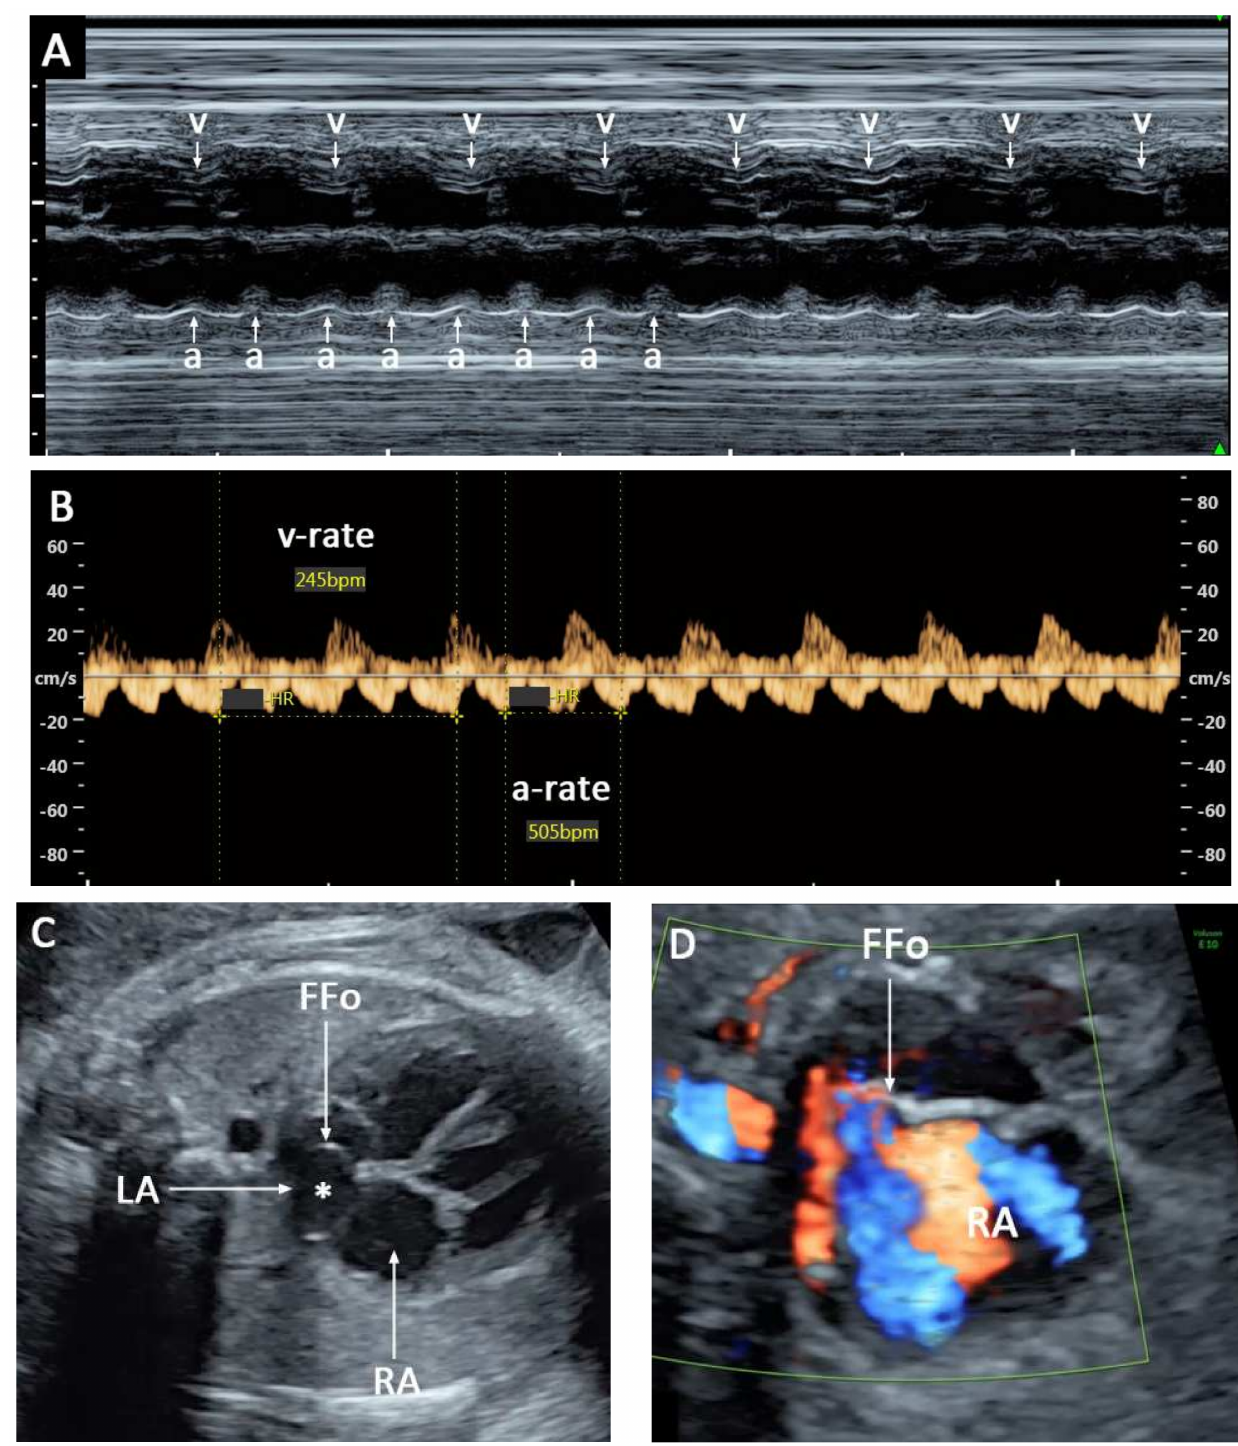
Figure 1. ( A ) M-mode shows a ventricular rate of (v) 245 bpm and an atrial rate of (a) 490 bpm; ( B ) Doppler waveforms of the renal vein (a-rate: 245 bpm) and renal artery (v-rate: 505 bpm); ( C ): Atrial septal aneurysm (*): wide excursion of the foramen ovale flap; ( D ): Color flow mapping in the septal aneurysm shows turbulent reversed flow returning back to the right atrium (FFo: flap of foramen ovale; LA: left atrium; RA: right